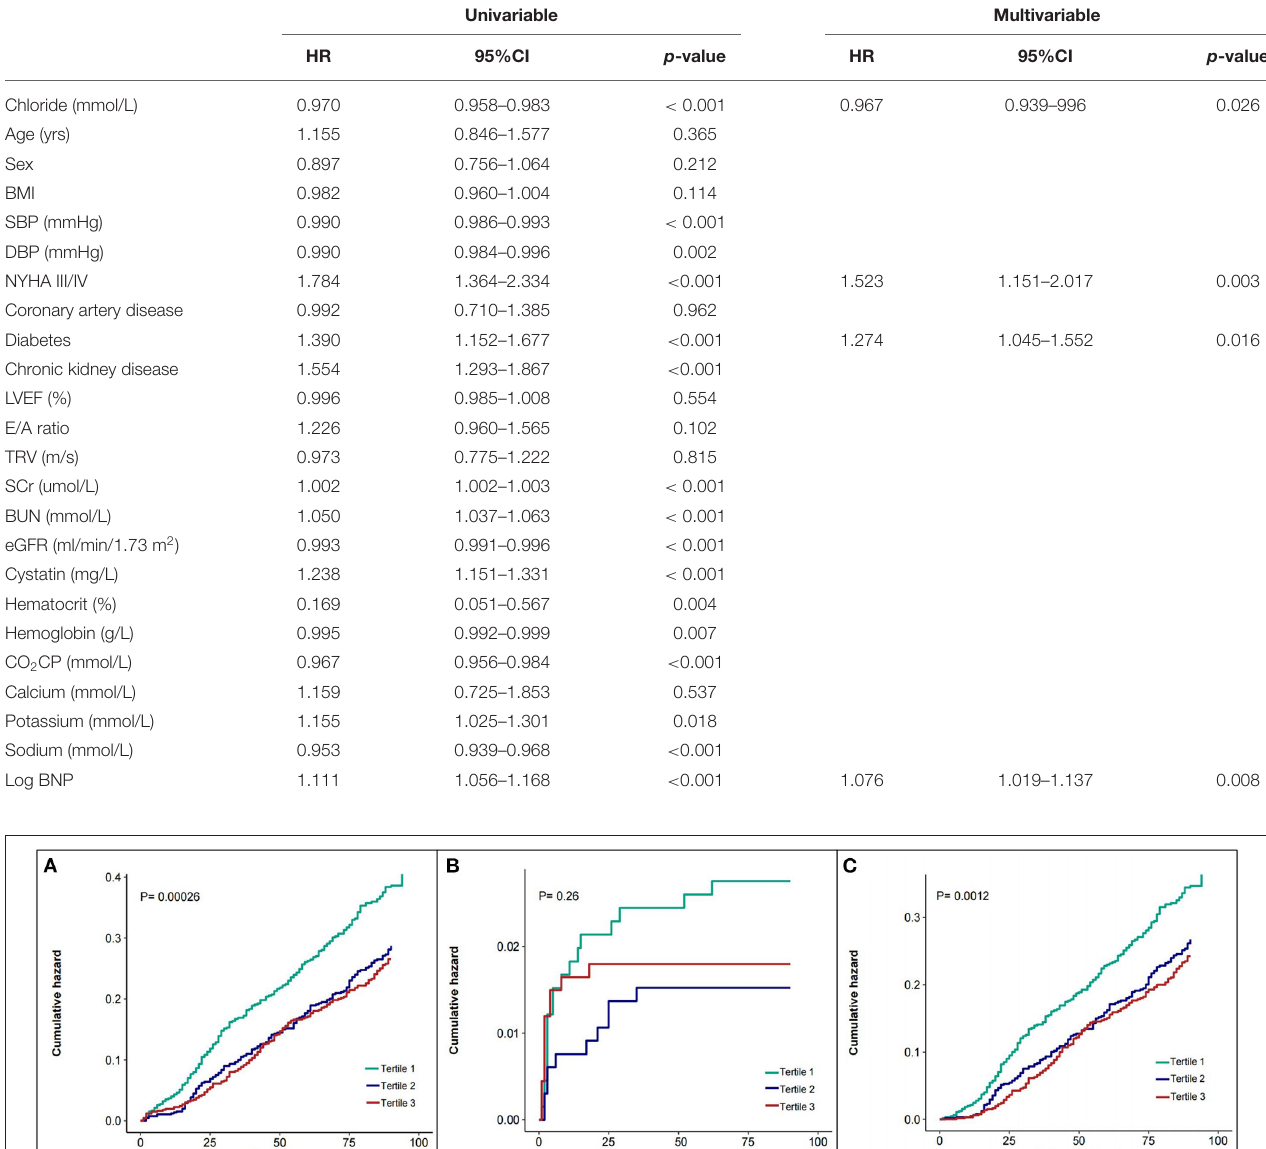
TABLE 2 | Univariable and multivariable cox proportional hazards models for composite endpoint. Univariable Multivariable